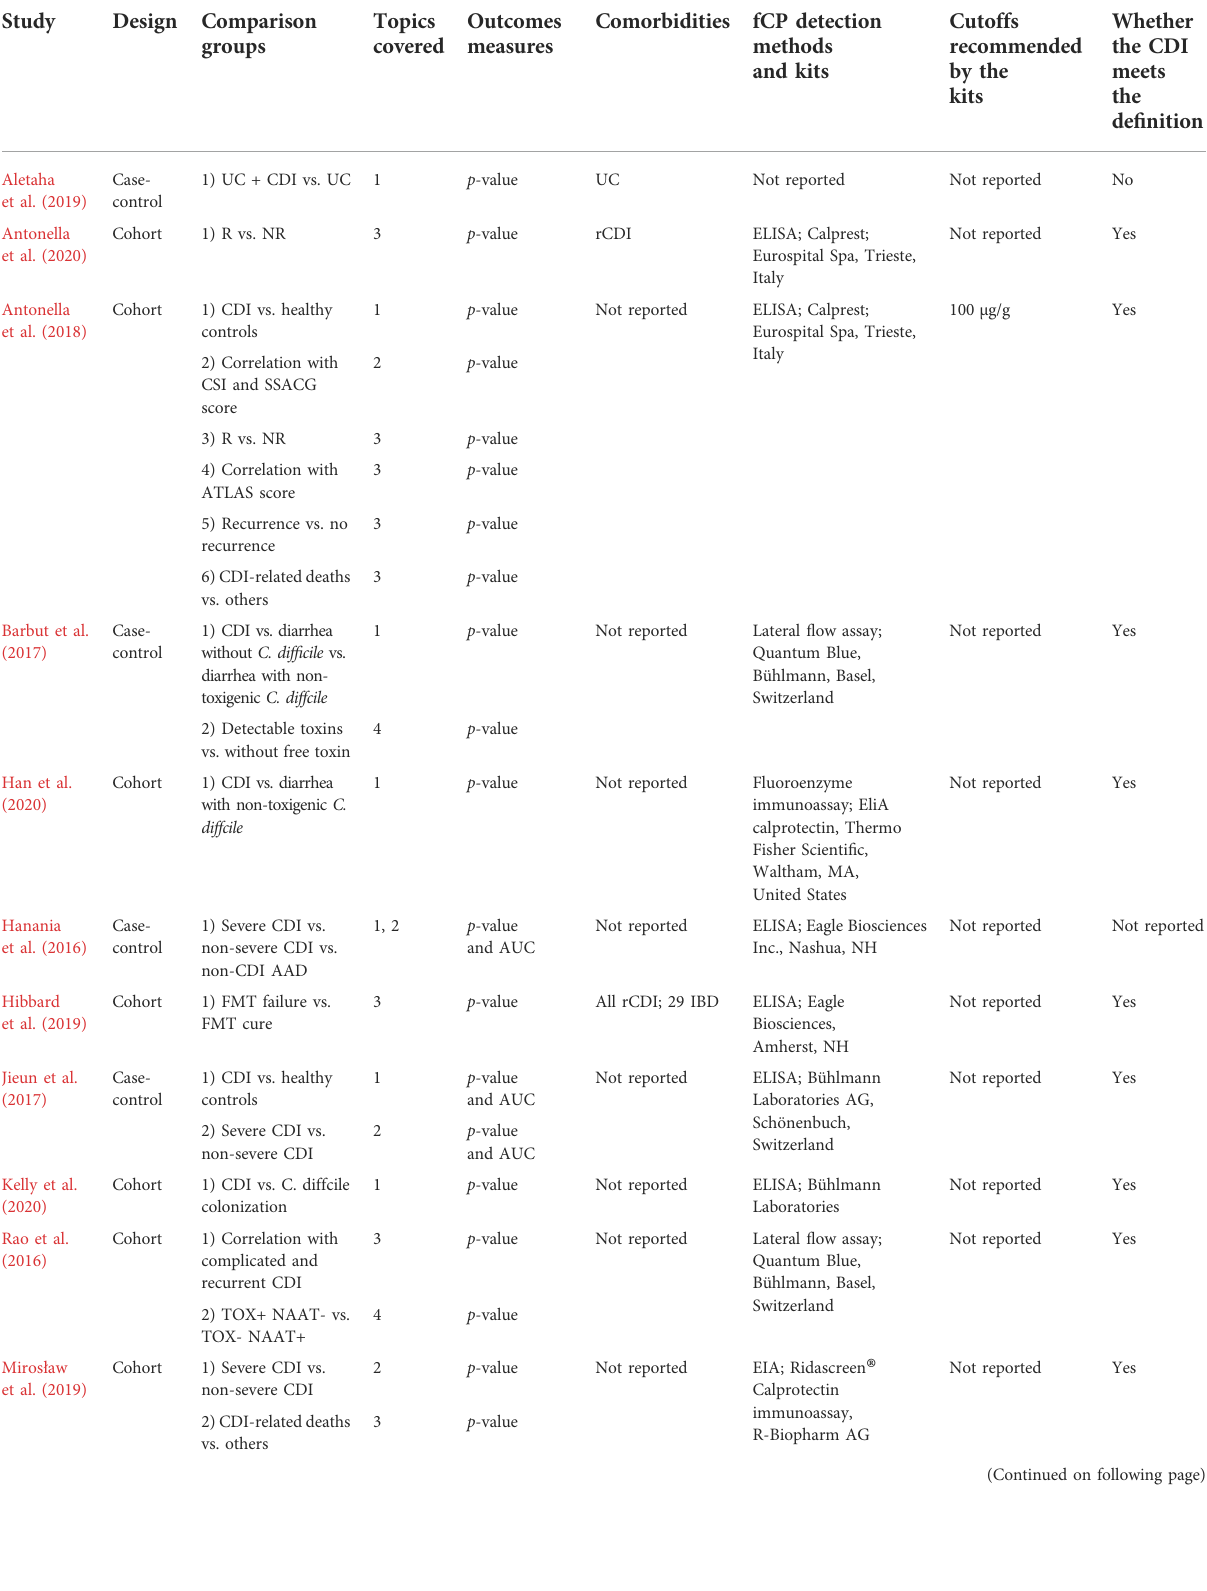
TABLE 2 Characteristics of included